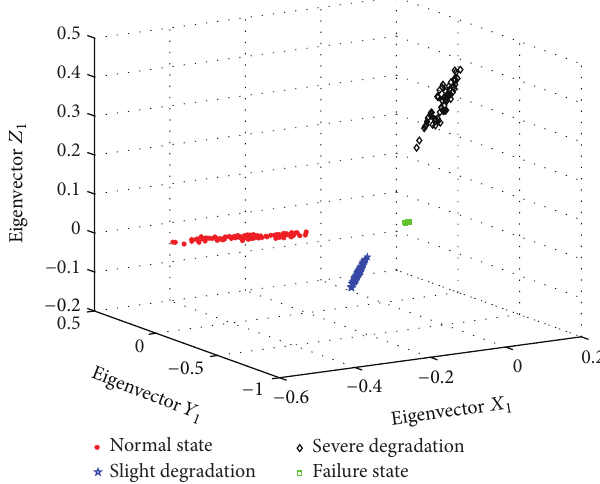
Figure 10: Space distribution of GA-LPP fusion features.